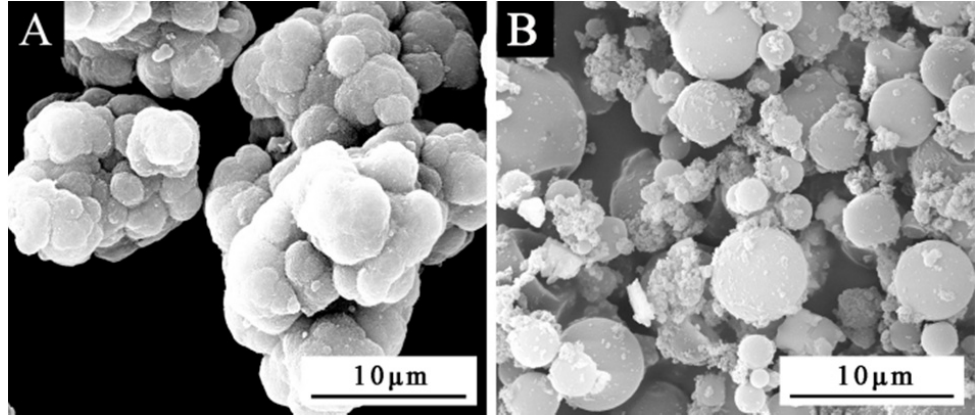
Figure 1. SEM diagram of microcapsules: ( A ) waterborne acrylic resin microcapsules, ( B ) fluorane microcapsules.